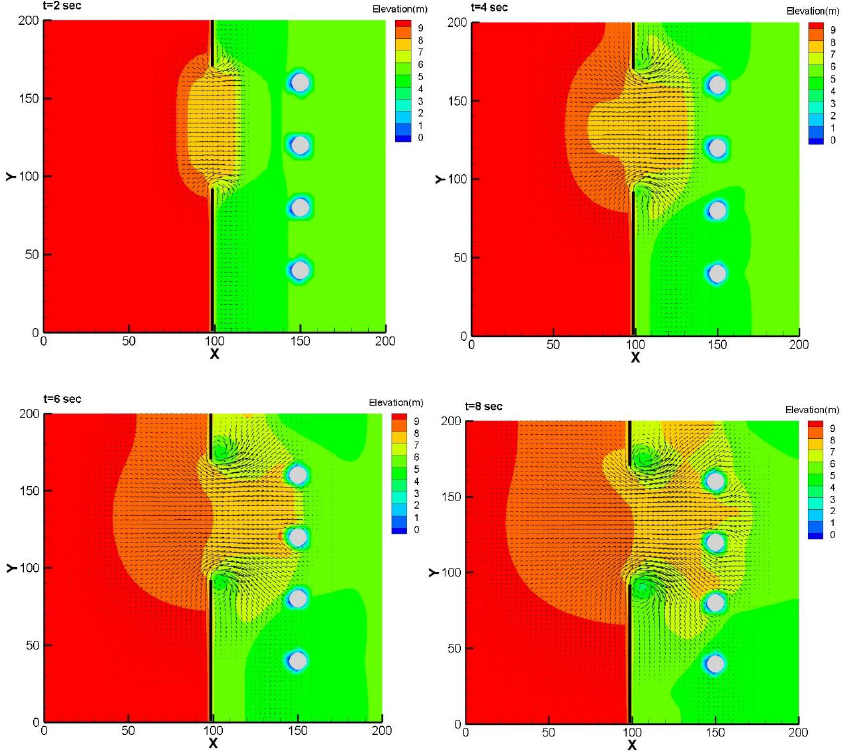
Figure 17. Evolution of free surface elevations and velocity distribution with four circular cylinders where the S x = 0.02 at the downstream.